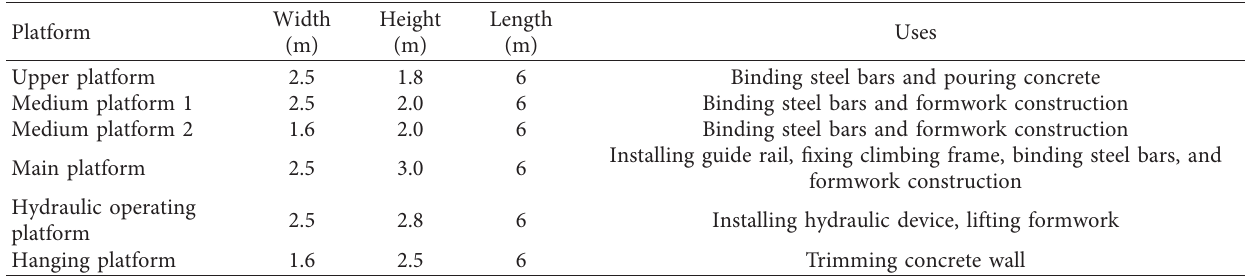
Table 1: Detailed sizes and uses of each platform of climbing